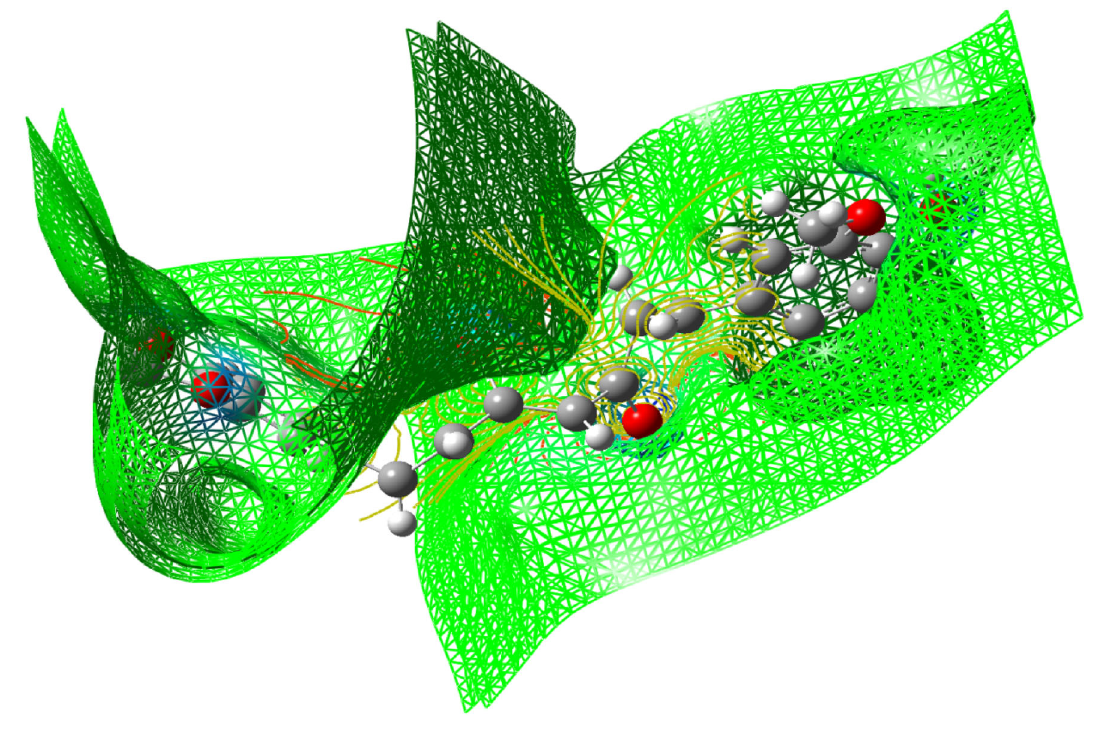
Fig. 14 The total electron density surface of curcumin